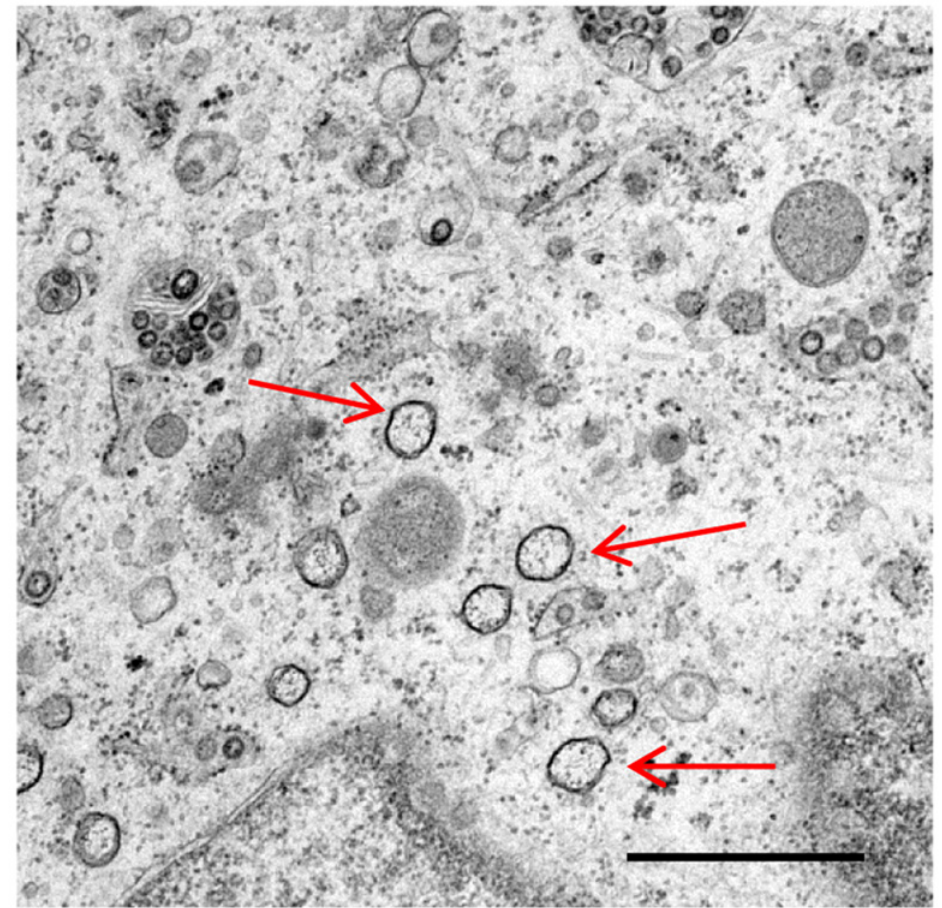
Figure 1. Double membrane vesicles induced by infectious bronchitis virus infection of Vero cells. Vero cells were infected with the Beau-R strain of IBV. Cells were glutaraldehyde fixed at 16 h post infection and prepared for transmission electron microscopy (TEM). Double membrane vesicles are indicated by arrows, scale bar indicates 1